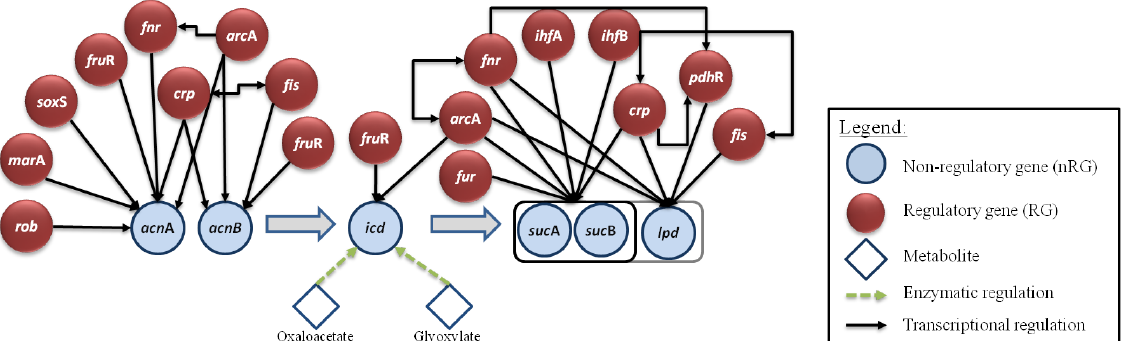
Figure 4: Examples of the long-term regulation affecting the “Citric Acid Cycle”. From the three sequential reactions in this pathway, only isocitrate dehydrogenase encoded by the icd gene is both regulated at the transcriptional and enzymatic levels. In contrast, the two aconitases encoded by acn A and acn B genes, and the 2-oxoglutarate dehydrogenase complex ( suc A- suc B- lpd ) are only regulated at the transcriptional